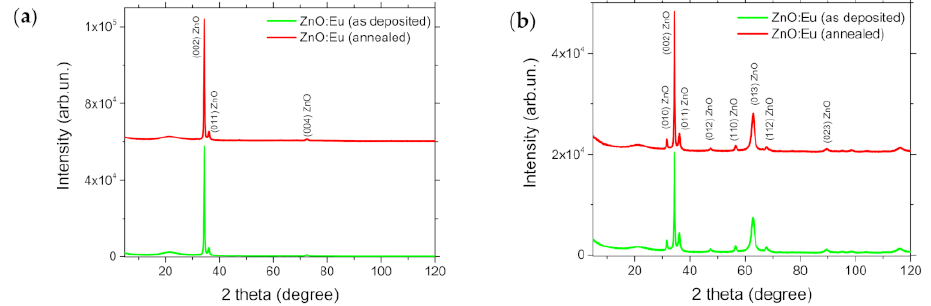
Figure 5. XRD patterns of ZnO:Eu thin film (as deposited and after PLA processing, 800 shots), ( a ) 2theta-omega and ( b ) grazing incidence